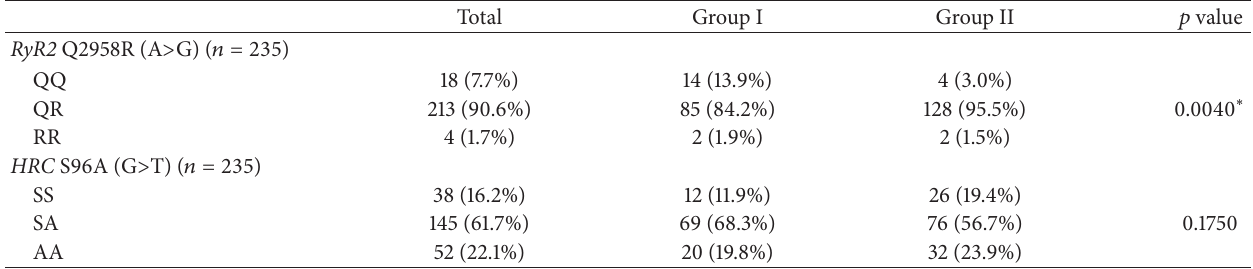
Table 3: Genotypic frequency of the two analyzed polymorphisms in the study population and according to arrhythmias occurrence.